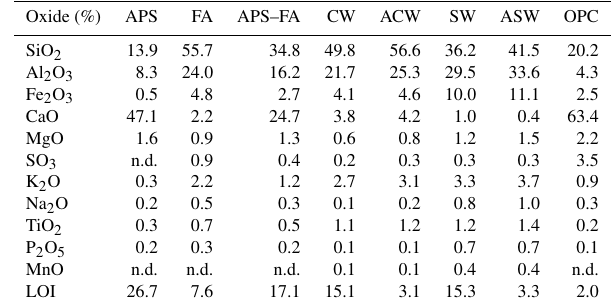
Table 2. Chemical characterisation by XFR of the materials in this